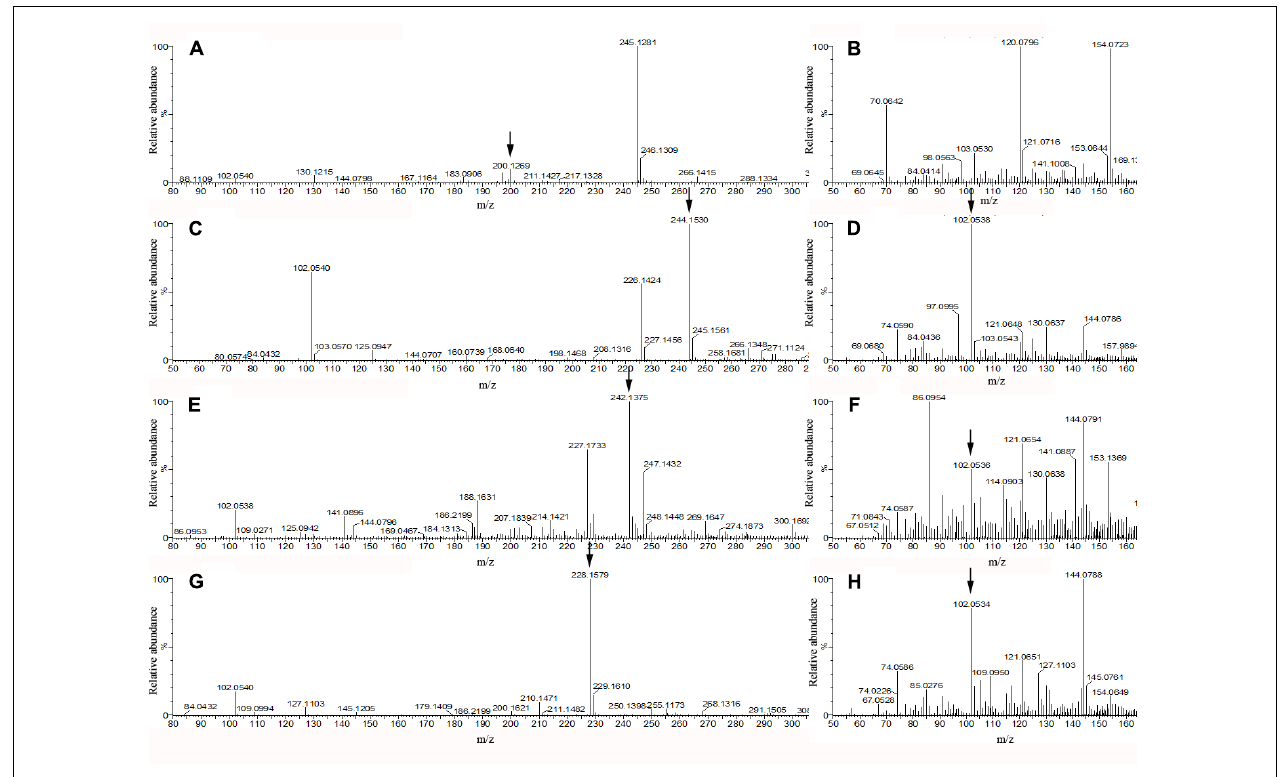
FIGURE 4 | QTOF-MS spectra of four AHLs of A. veronii LP-11 extract. Panels (A,B) were the MS1 spectra and MS2 spectra, respectively of m/z 200.1269 ion; panels (C,D) were the MS1 spectra and MS2 spectra, respectively of m/z 244.153 ion; panels (E,F) were the MS1 spectra and MS2 spectra, respectively of m/z 242.1375 ion; and panels (G,H) were the MS1 spectra and MS2 spectra, respectively of m/z 228.1579 ion. TABLE 2 | HPLC/qTOF-MS analysis of AHLs isolated from A. veronii LP-11extract. Compound Retention time/min Calculated formula Mass (Da) Calculated mass /(Da) Error/mDa